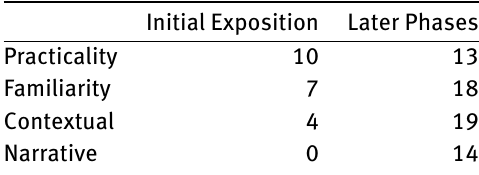
Table 14: Exposition Phase vs Later Phases and Referenced